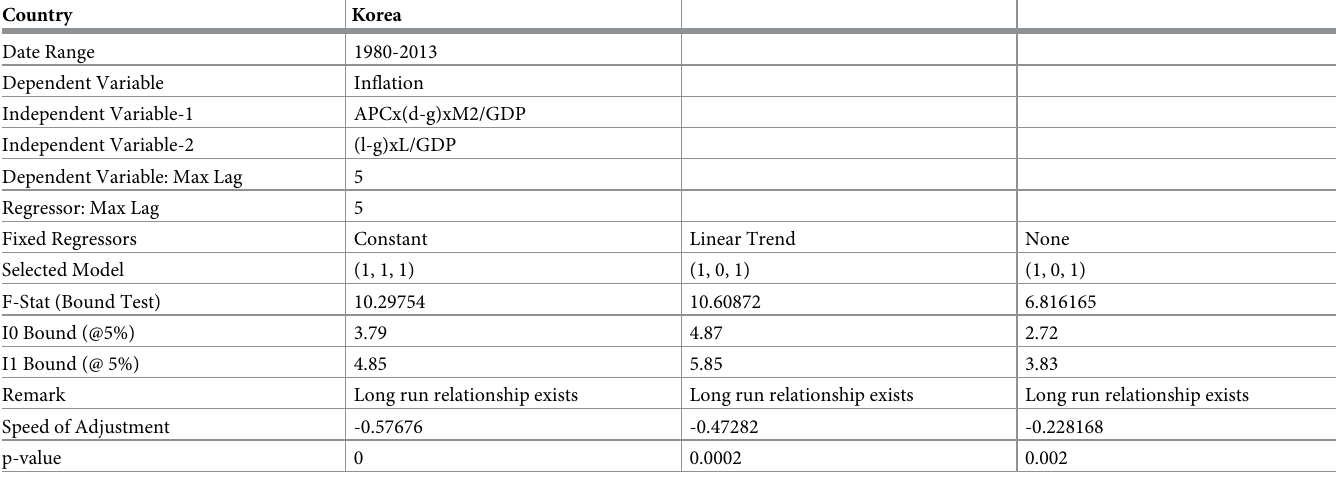
Table 23. ARDL Bounds Testing for Korean data under proposed